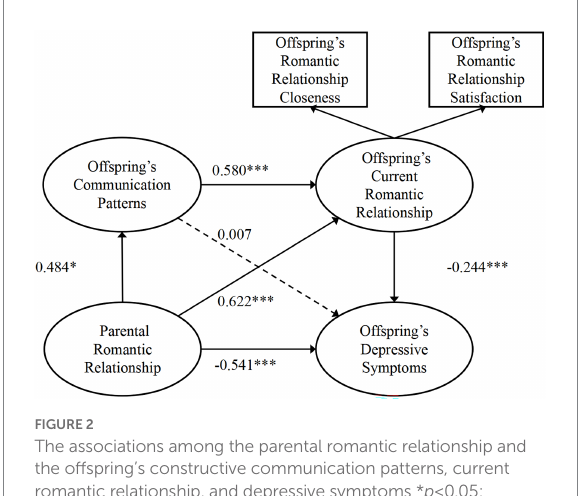
FIGURE 2 The associations among the parental romantic relationship and the offspring’s constructive communication patterns, current romantic relationship, and depressive symptoms * p < 0.05; ** p < 0.01; *** p <